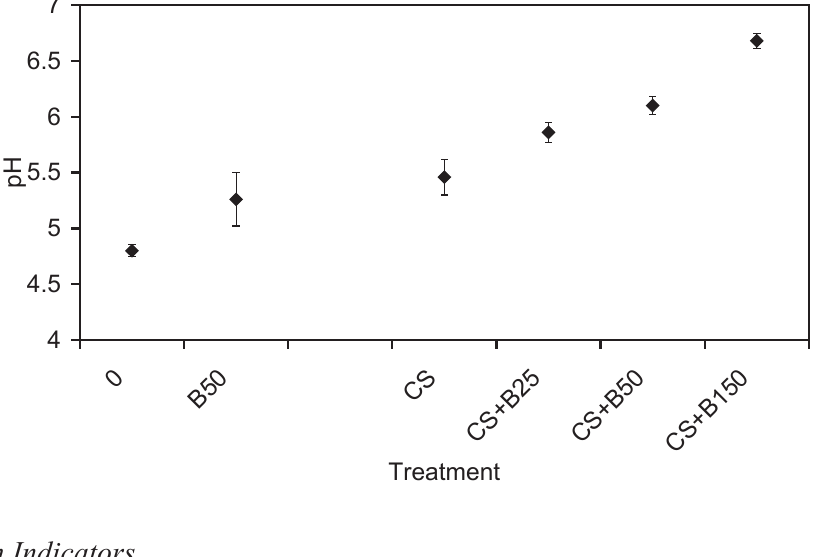
Figure 1. Mean and standard error values for pH readings in different soil